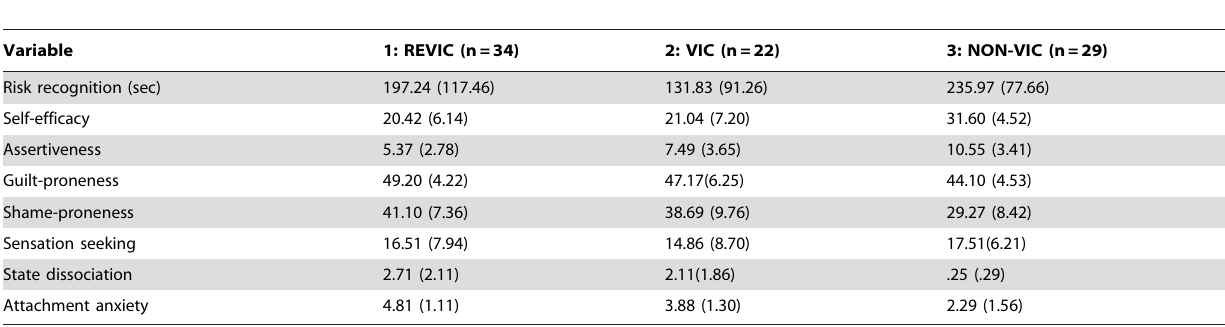
Table 4. Descriptive statistics: Means and standard deviations (in parentheses) of potential risk factors for revictimization across all three groups.